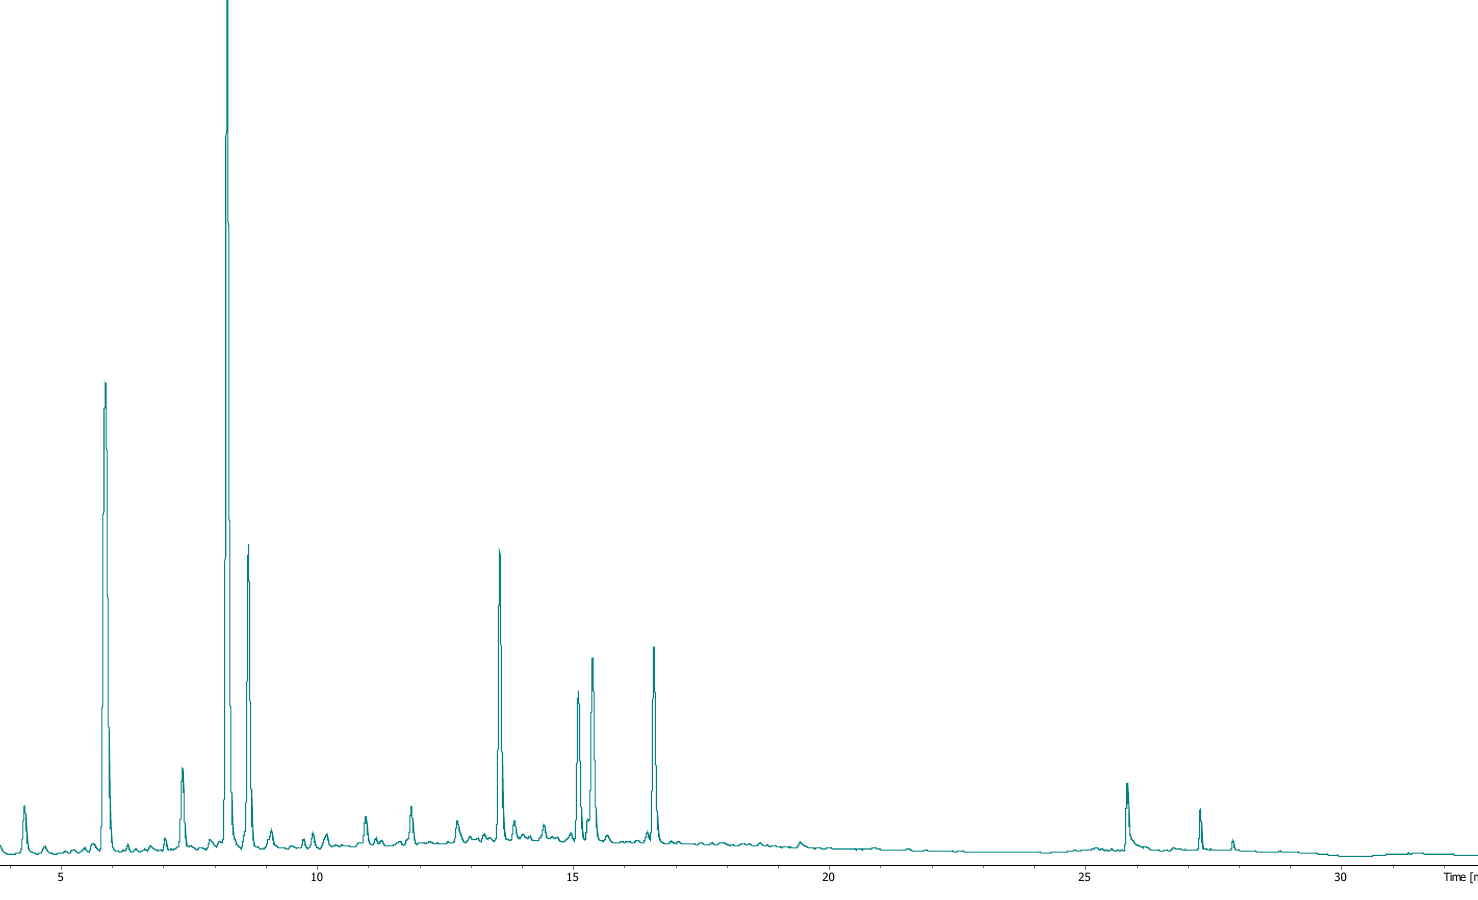
Figure A5. Ilex aquifolium ‘Argentea Marginata’ leaves water extract, UV chromatogram, 280 nm.